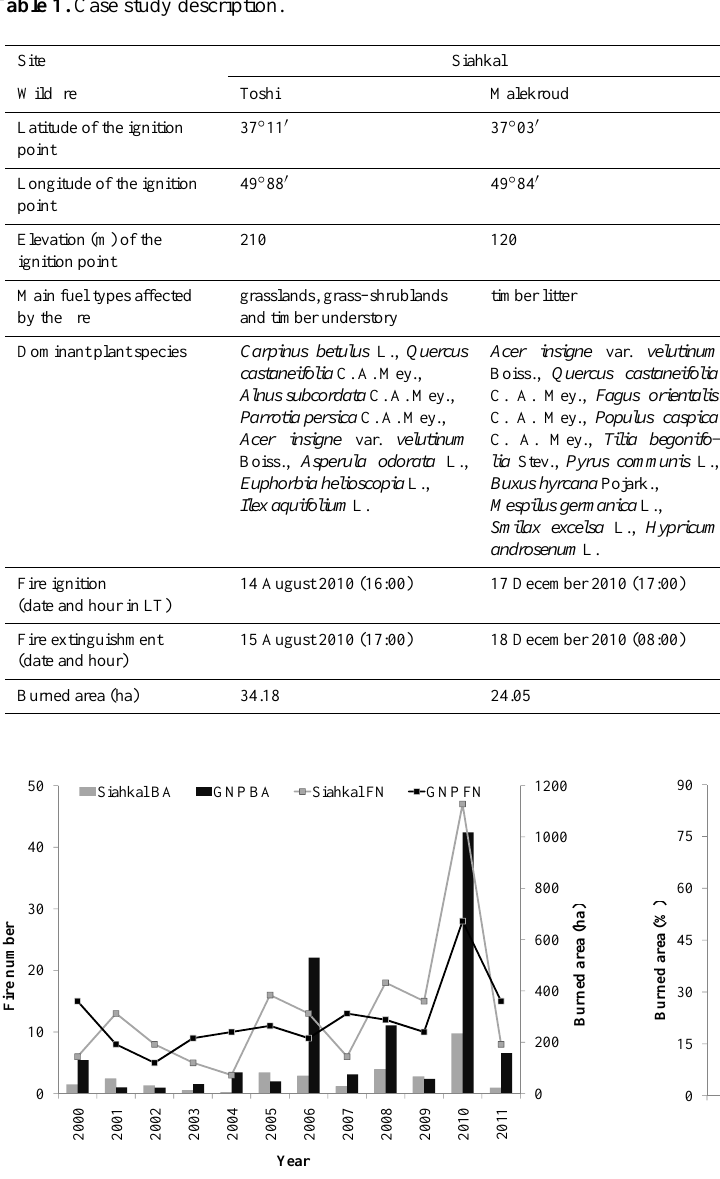
Figure 4. Historical relationship between fire size categories and percentage of fire number (FN) and burned area (BA) in Siahkal for- est area and GNP (2000–2011; data from Department of Forestry, Natural Resources Office, Guilan, and Department of Environment, Golestan, Iran, personal communication, 2011,